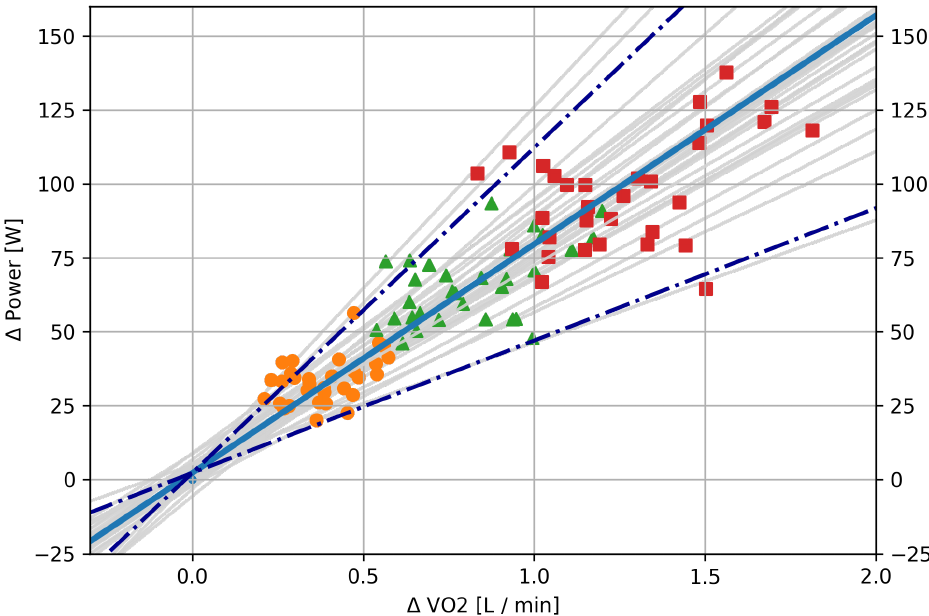
Figure 2. Change in respiratory ˙VO 2 vs. change in running power, as measured by the Stryd sensor, during the combined incremental and ramp exercise test. The first stage was used as the baseline for each of the participants (Point 0, 0). Orange circle = Stage 2; green triangle = Stage 3; red square = Stage 4. Between stages, the treadmill speed was increased by 0.5 m · s − 1 . There was a strong correlation between ˙VO 2 and power (cf. blue line, r = 0.95). Dashed-dotted blue lines show a slope error of 2 standard deviations. Best viewed in